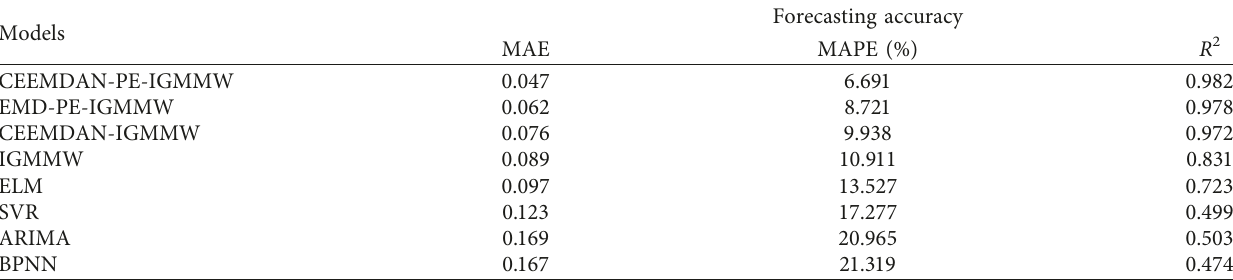
Figure 15: Analysis of degradation tendency prediction results in terms of MAE, MAPE, and R 2 . Table 5: Analysis of forecasting accuracy of eight models.